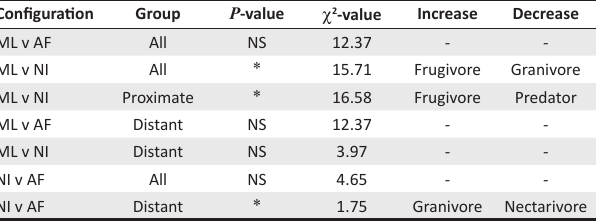
FIGURE 2: The percentage contribution of each bird feeding guild to the total species richness of the three fynbos configurations: mainland, natural islands and artificial fragments. TABLE 1: Results from modified chi-squared tests of avifaunal feeding guild distributions between the different habitat configurations. Configuration